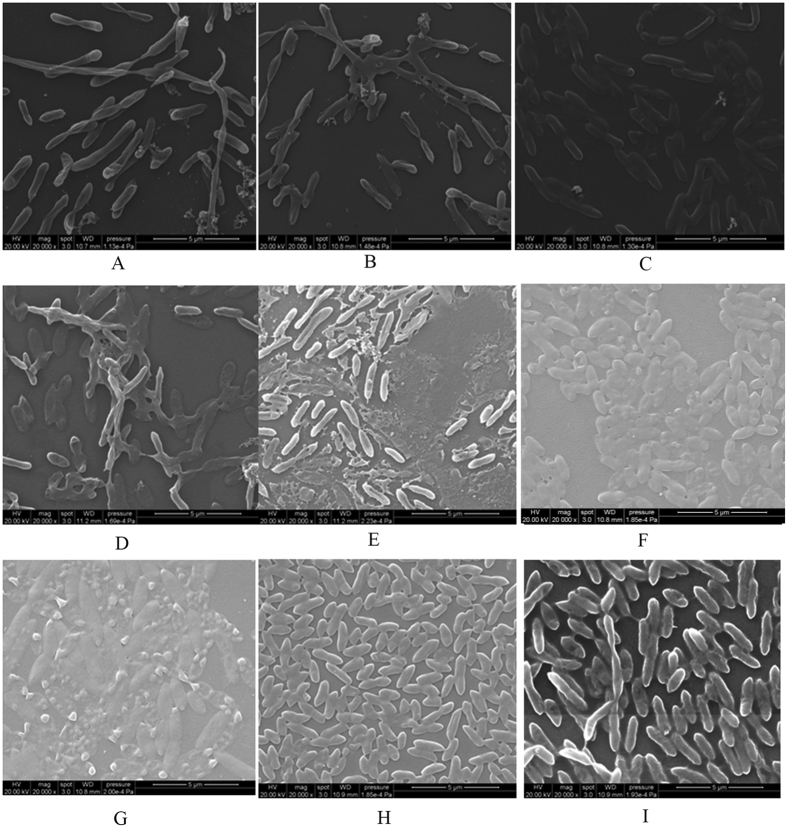
Scanning electron microscopy images of biofilms of one S. maltophilia strain (10275), treated with moxifloxacin for 4 h (A–C), 10 h (D–F) and 18 h (G–I).The concentrations of moxifloxacin were: 10 μg/mL (A,D,G), 50 μg/mL (B,E,H), 100 μg/mL (C,F,I). Magnification: ×20,000.